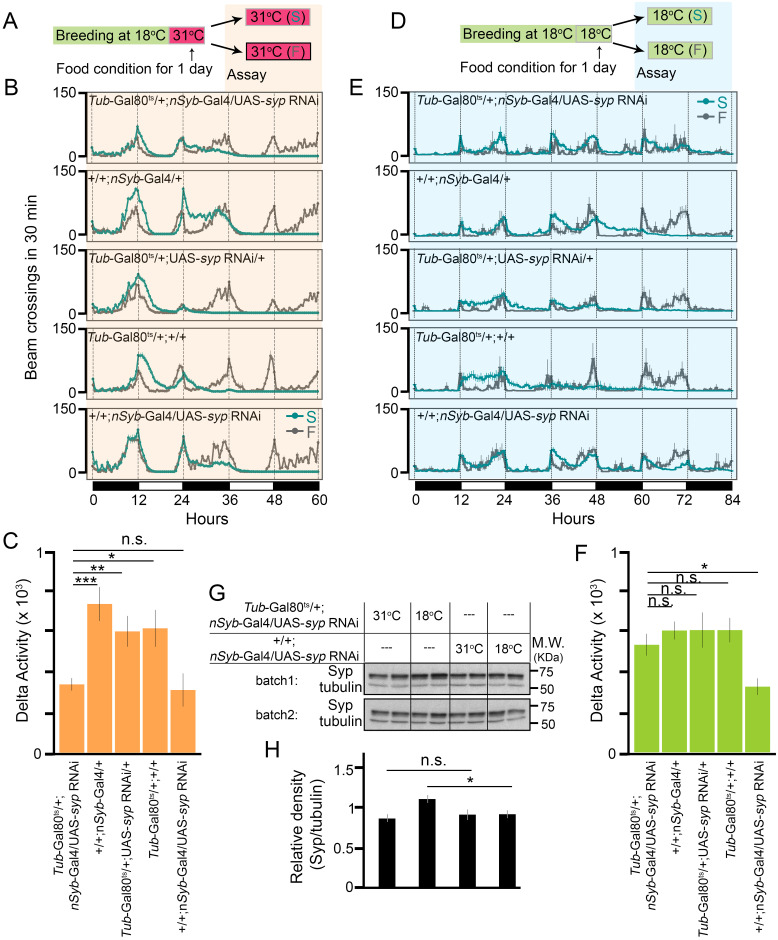
Syp in adult neurons regulates SIH.(A) Breeding and testing scheme. S: starvation condition; F: food condition. (B) Locomotor activity responses to starvation from each genotype under the condition shown in panel A. Gray lines represent activities under the food condition (F) and green lines represent activities under the starvation condition (S). n = 24-30 per genotype per condition. (C) Summary plot of SIH from each genotype in panel B. (D) Breeding and testing scheme. S: starvation condition; F: food condition. (E) Locomotor activity responses to starvation from each genotype under the condition shown in panel D. n = 8-28 per genotype per condition. (F) Summary plot of SIH from each genotype in panel E. (G) Western blot of adult fly head homogenate from Tub-Gal80ts/+;nSyb-Gal4/UAS-syp RNAi (ts-syp-KD) and +/+;nSyb-Gal4/UAS-syp RNAi (syp-KD) flies. Four biological replicates per genotype per condition. Tubulin is the loading control. (H) Quantification of Syp from four biological replicates. * P < 0.05, ** P < 0.01, *** P < 0.001, n.s.: P > 0.05, unpaired t-test with Bonferroni Correction. Error bars represent SEM.